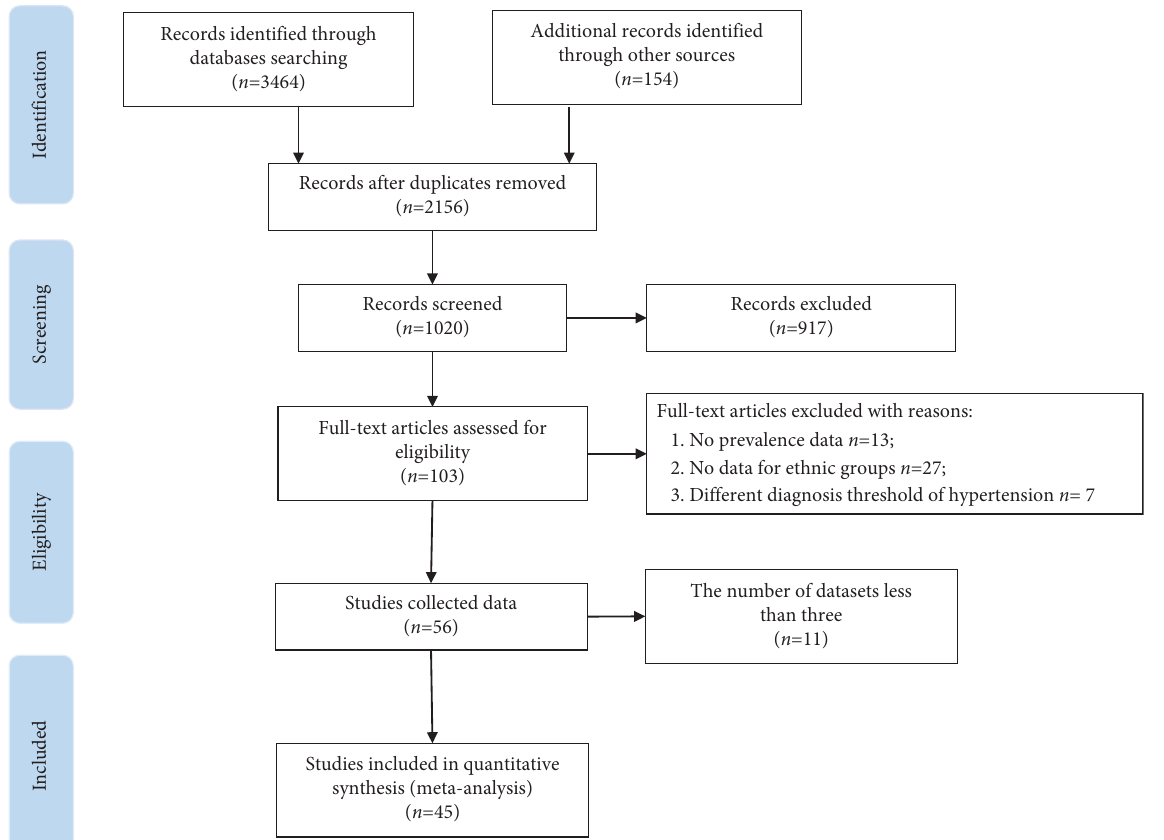
Figure 1: Literature search